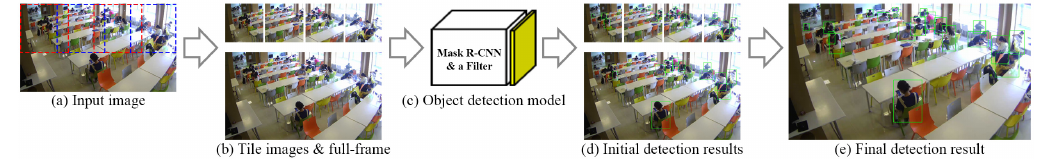
Figure 3. Proposed person detection